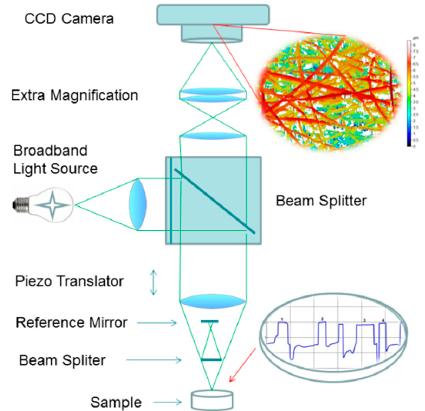
Figure 2. Schematic diagram of scanning white light interferometer (SWLI) and the experimental setup for the in situ wetting and early-stage dissolution of nanofibers. for the in situ wetting and early-stage dissolution of